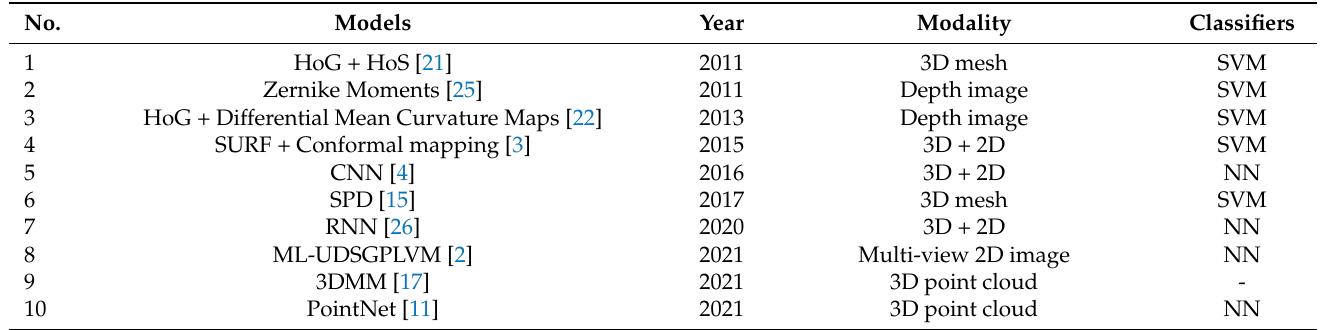
Table 1. Representative methods related to 3D FER emerged in recent years; a trend can be seen in terms of using raw data to learn representations for